Question: Describe this figure in one sentence.
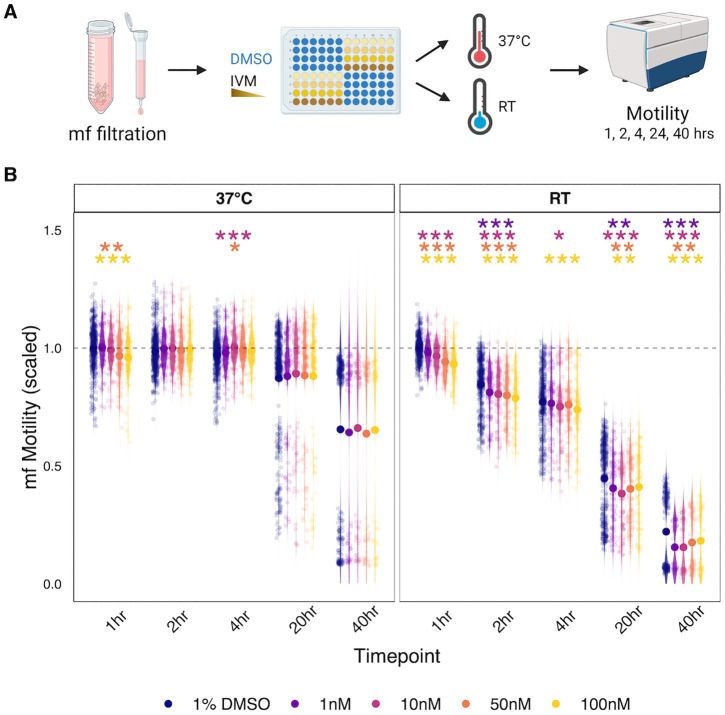
Answer: Temperature modulates ivermectin sensitivity of Brugia microfilarial motility. (A) Schematic showing methodology and timeline for mf temperature shift assay. Created in BioRender. Zamanian, M. (2026) https://BioRender.com/zlga3u6 . (B) Mean motility, scaled to DMSO 1 hour values of B. pahangi mf at 37℃ (left panel) and room temperature (RT, right panel) across time and ivermectin (IVM) or control treatment concentrations (color-coded). P-values represent statistical differences in mf motility between DMSO and drug treatments at matched time points and temperature and were calculated using Anova/Tukey post-test and significance reported as follows, *: p < 0.05, **: p < 0.01, ***: p < 0.001. Each plot point represents measurements for a plate well containing 1000 mf; each condition was performed across at least six technical replicates (wells) per experiment and each experiment was repeated for at least three biological replicates (parasite cohorts).